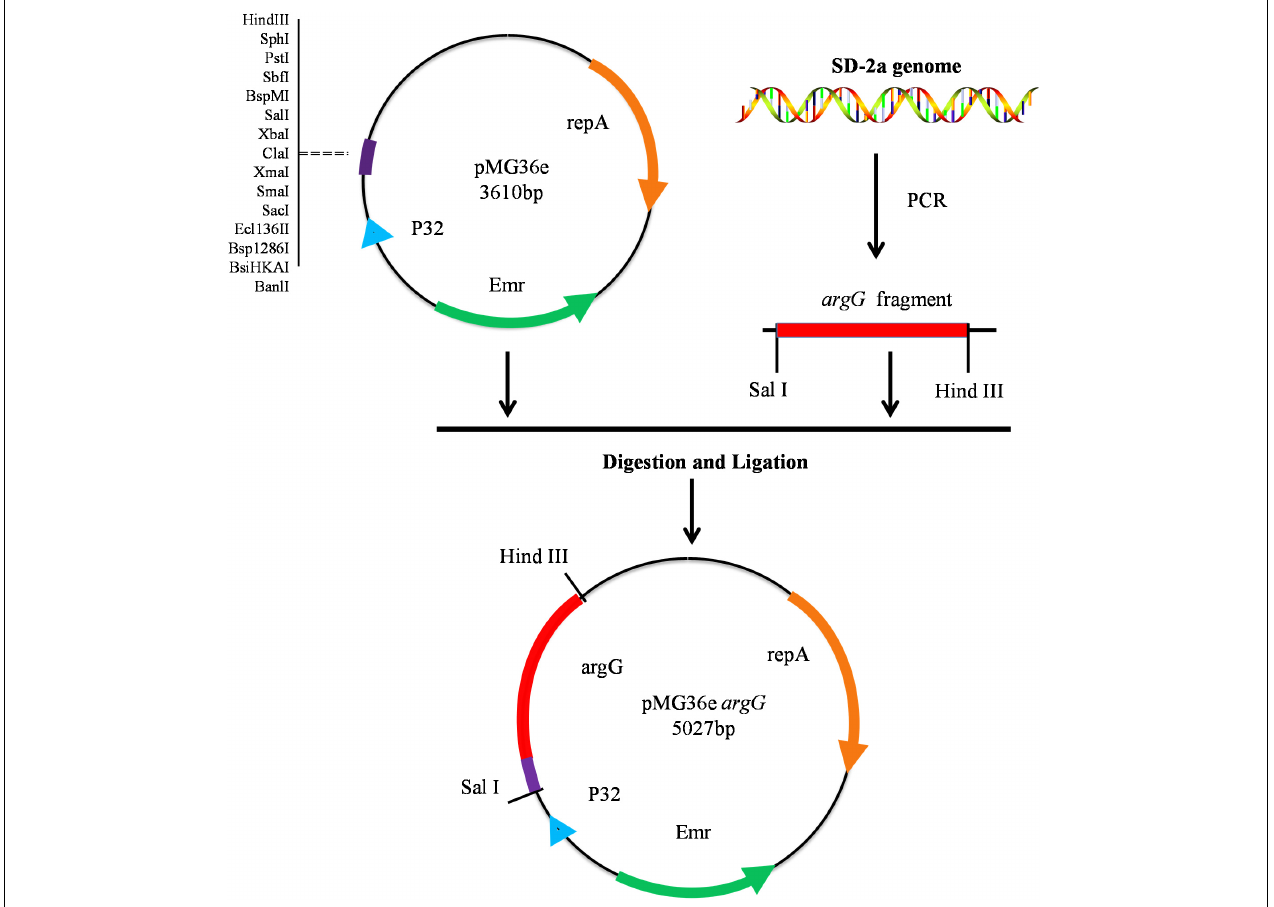
FIGURE 1 | Construction of recombinant expression vector pMG36e